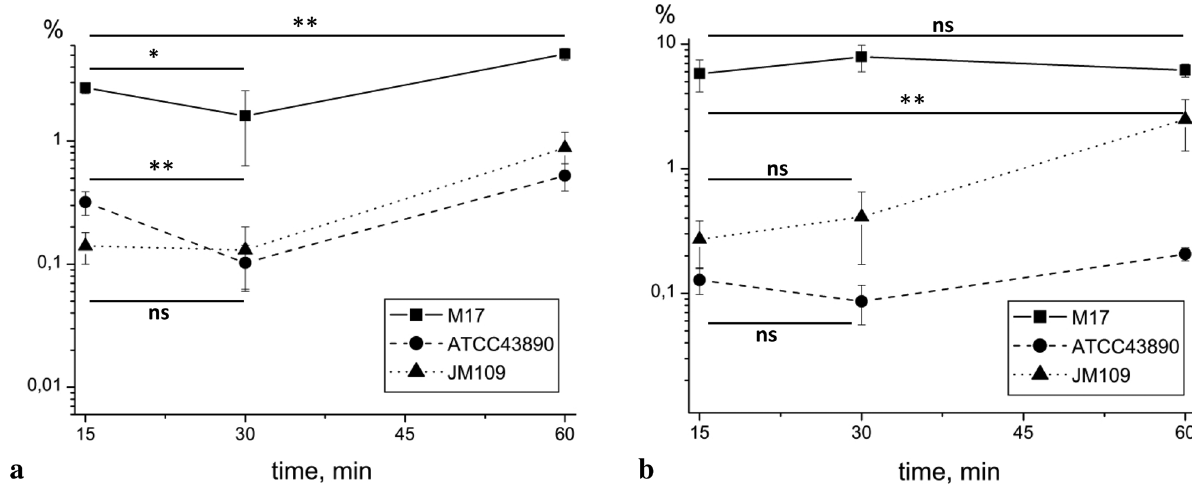
Figure 6. Efficiency of adhesion among different E. coli strains to ( a ) plastic and ( b ) HEp-2 cell line. ns—not significant, * p < 0.05, ** p < 0.01. Additional information related to statistical analysis see in a